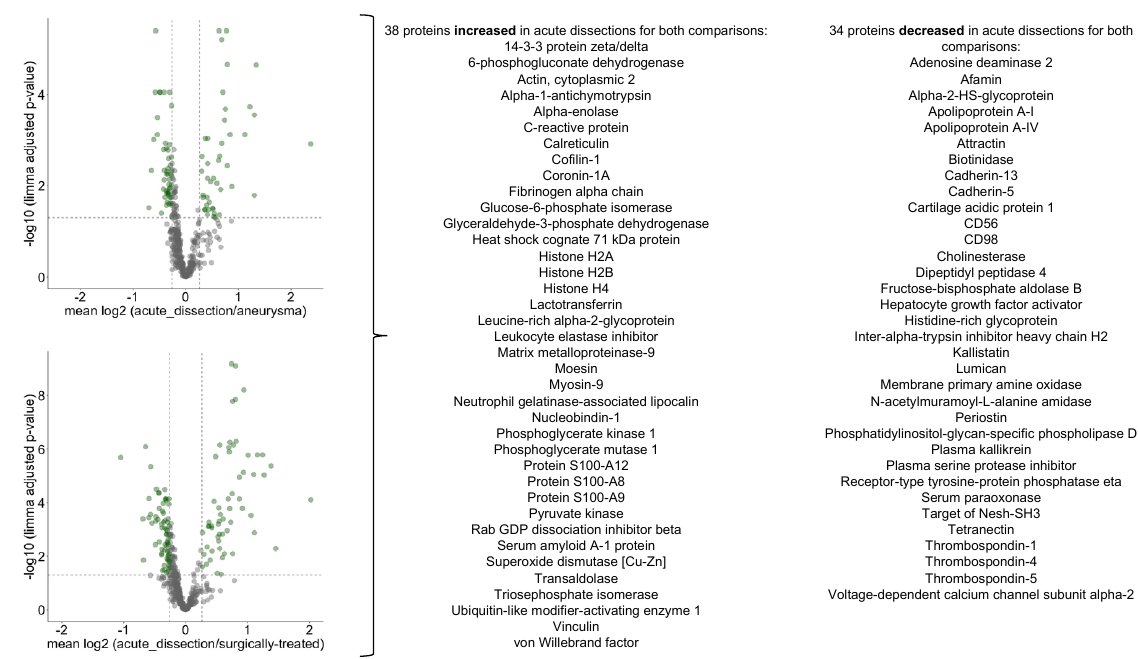
Figure 7. Volcano plots highlighting differentially abundant proteins for the comparison of acute dissections vs. aneurysms or surgically treated dissections.